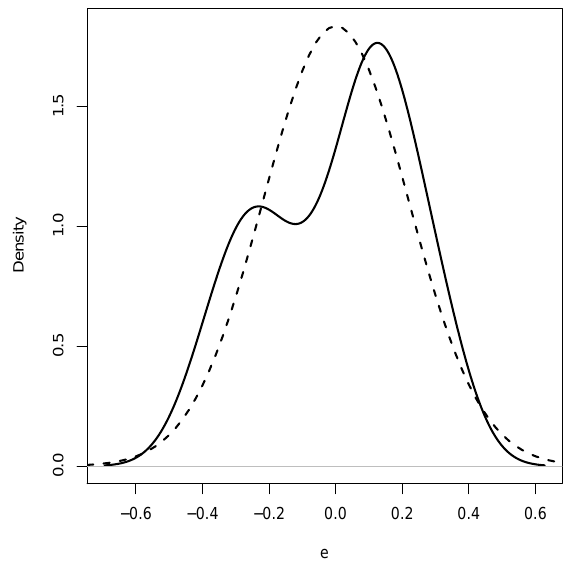
Figure 3. Kernel density estimate for differences in item difficulties δ i = b i 2 approximation displayed by a dashed